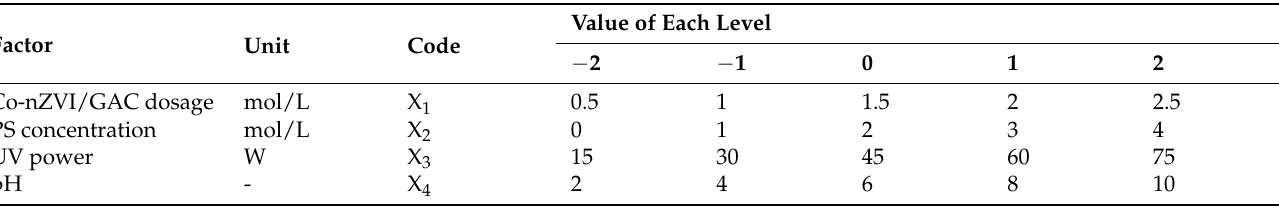
Table 1. Design experimental factor